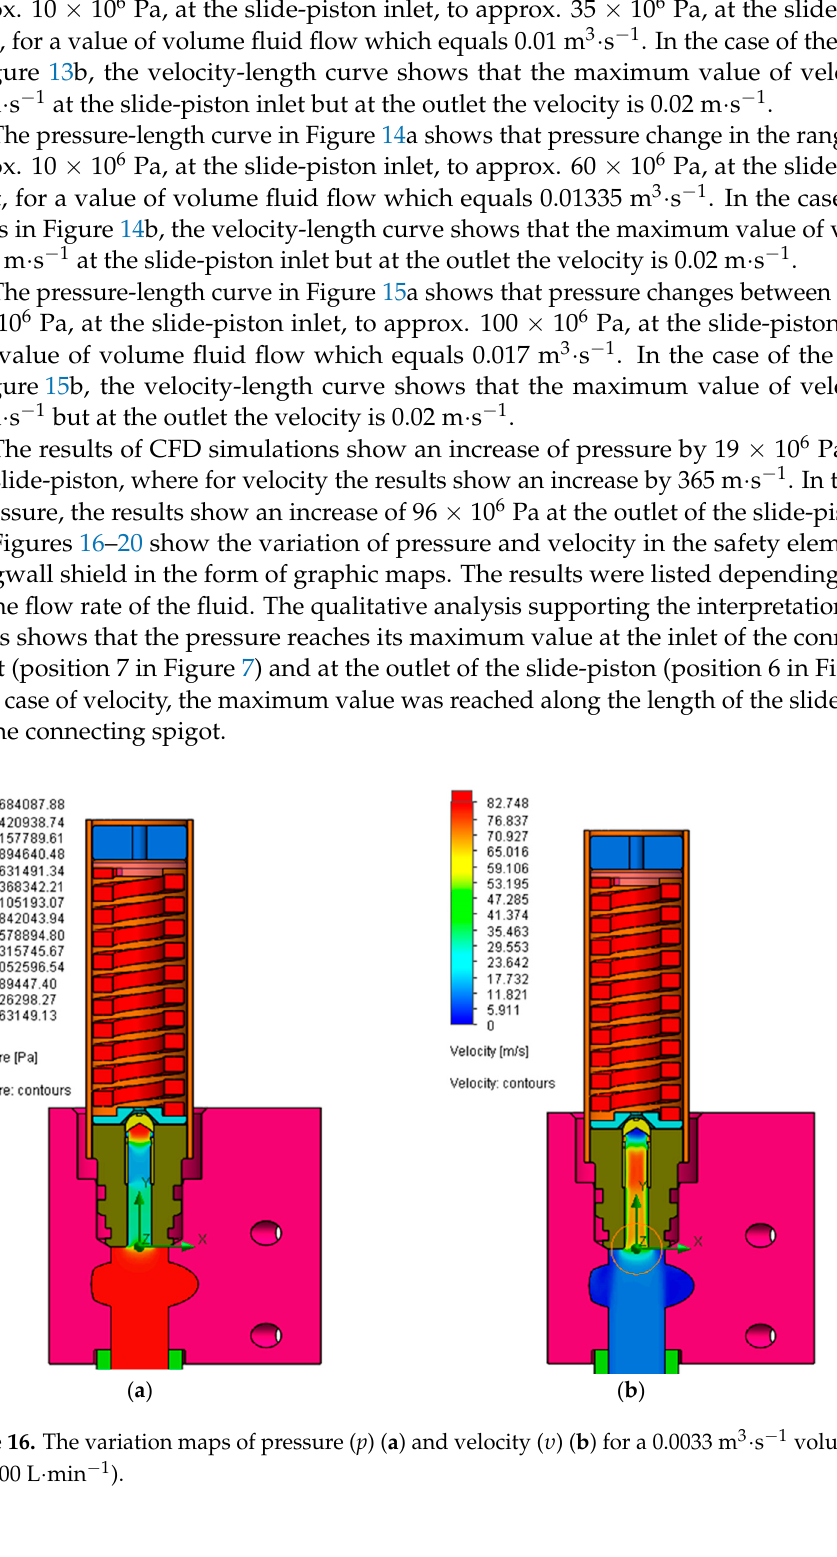
Figure 15. The variation curves of pressure ( p ) ( a ) and velocity ( υ ) ( b ) for volume flow rate 0.017 m 3 ·s -1 (1020 L·min -1 ).